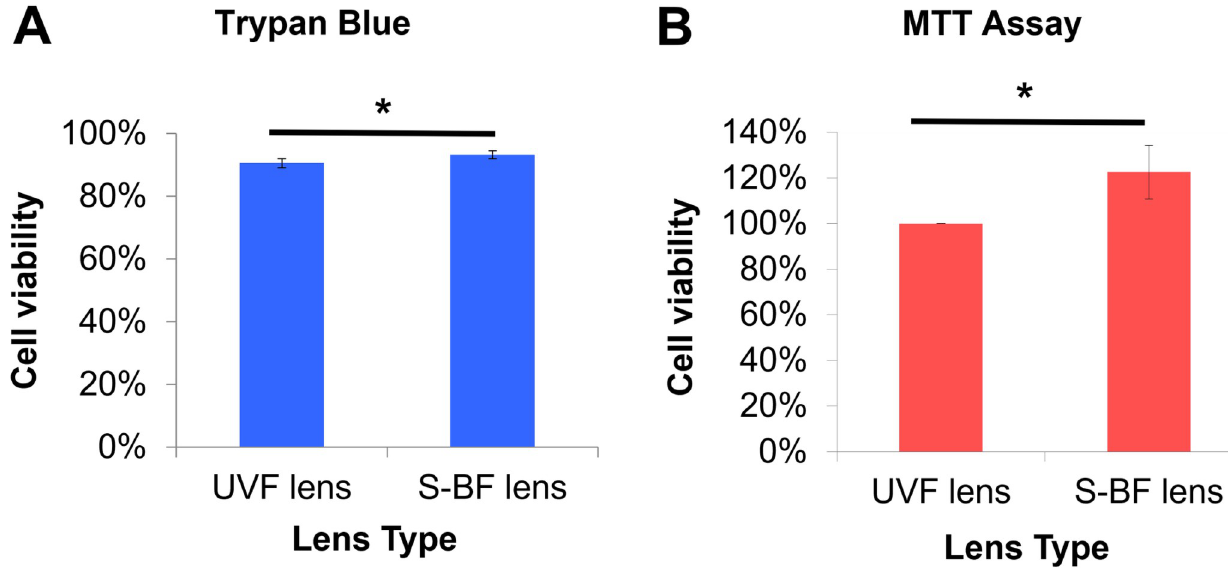
Fig 7. Selective Blue-Filtering (S-BF) lens protected RPE cells from blue light irradiation-induced cytotoxicity. (A) Under blue LED irradiation, S-BF lens showed significantly elevated viability compared to the UV-filtering (UVF) lens (93.4 ± 1.4% vs 90.6 ± 1.4%) using trypan blue (p = 0.022) assay. (B) MTT assay also revealed that S-BF lens increased cellular viability by 22.5% (p = 0.029). (n = 3, t-test, � p < 0.05).